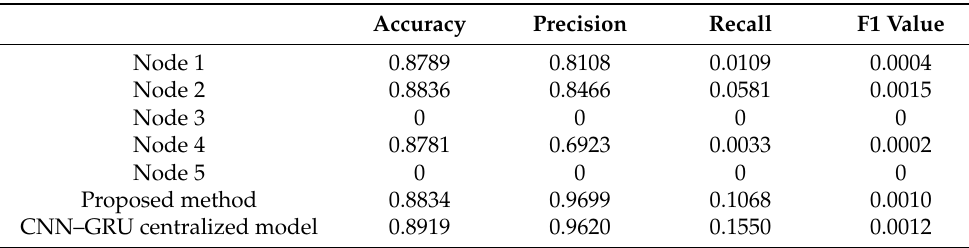
Table 5. FL (R2L) attack classification